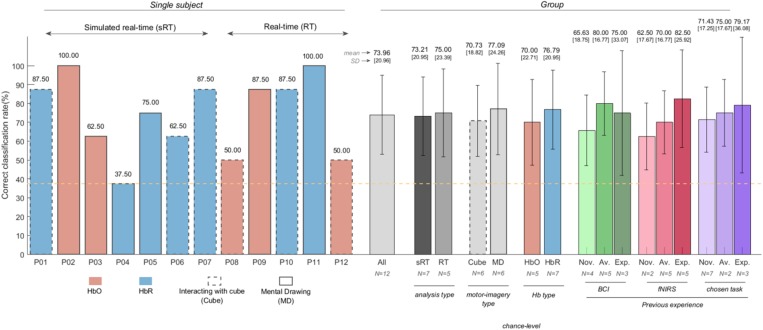
Choice-decoding accuracies obtained in (simulated) real-time (individual and group results) using HbX channel selection and SDC correction. All participants but P04 reached accuracies higher than chance-level (orange, dashed line). The face colors and line pattern of the bar plots of each subject (left-half of the figure) represent the selected Hb-type and strategy participants chose to perform, respectively. Mean decoding accuracies and standard deviation of all participants and with different grouping factors can be found on the right-half of the figure. Groupings were based on the analysis type (simulated real-time vs. real-time), the motor imagery participants chose [interacting with the cube (cube) vs. mental drawing (MD)], the selected chromophore (HbO vs. HbR) and previous BCI experience (novices, average and experts). Participants with no previous BCI/fNIRS/task experience were considered novices; expert participants were those who had participated in more than five BCI experiments; the remaining participants were considered average (see Table 2). The integer after “N = ” indicates the number of participants employed in each computation.